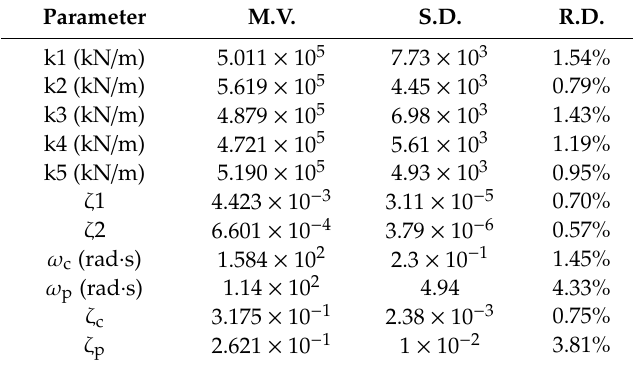
Figure 18. Marginal posterior probability distributions of the six estimation parameters ( k 1 , k 3 , k 5 , ζ 1 , ω p , ζ c ). Table 9. Summarizing statistics of the posterior parameter distribution (Mean Value (M.V.), Standard Deviation (S.D.), and Relative Deviation (R.E.)).